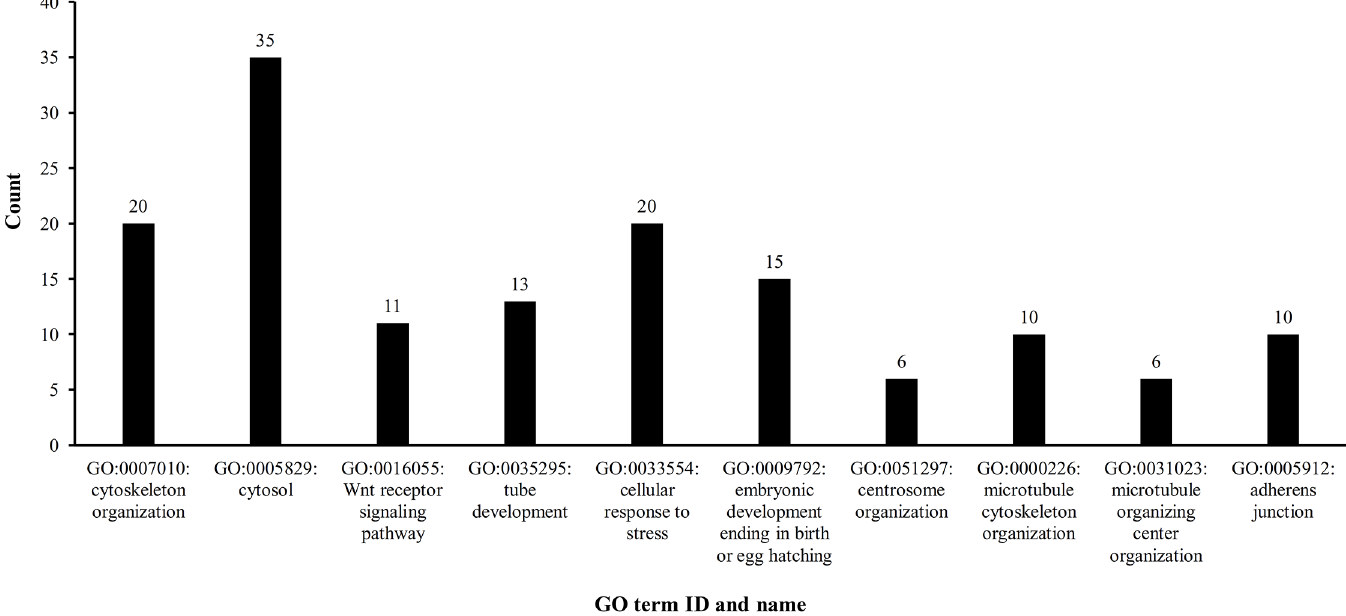
Fig 3. The top ten GO terms that were highly shared by 164 significant candidate genes. The X-axis indicates the GO term ID and name, while the Y- axis represents the number of genes that shared the pathway.